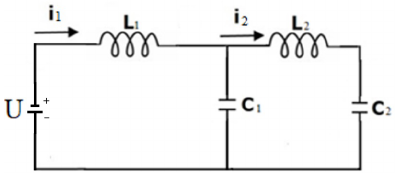
Figure 4. Electrical cascade model of the case under consideration created with the use of voltage analogy to mechanical